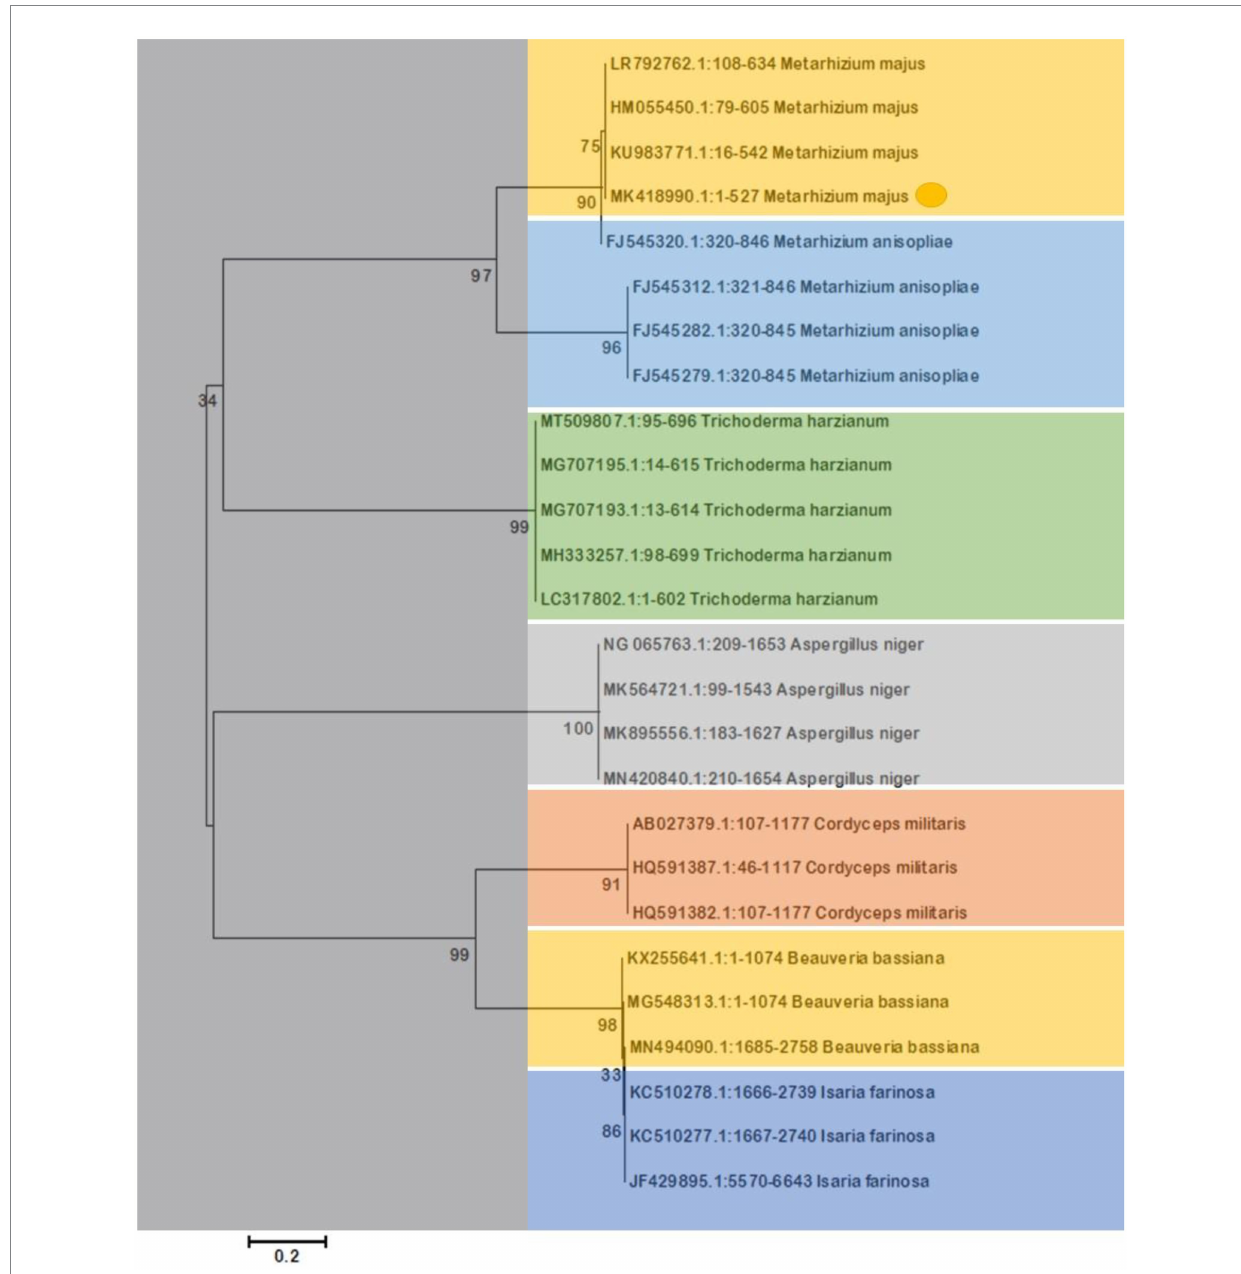
FIGURE 4 The Neighbor-Joining tree method was used to make a phylogenetic tree of the stages of evolution of entomopathogenic fungi that had been isolated. Our isolated fungal strains showed 100% similarity with Metarhizium majus